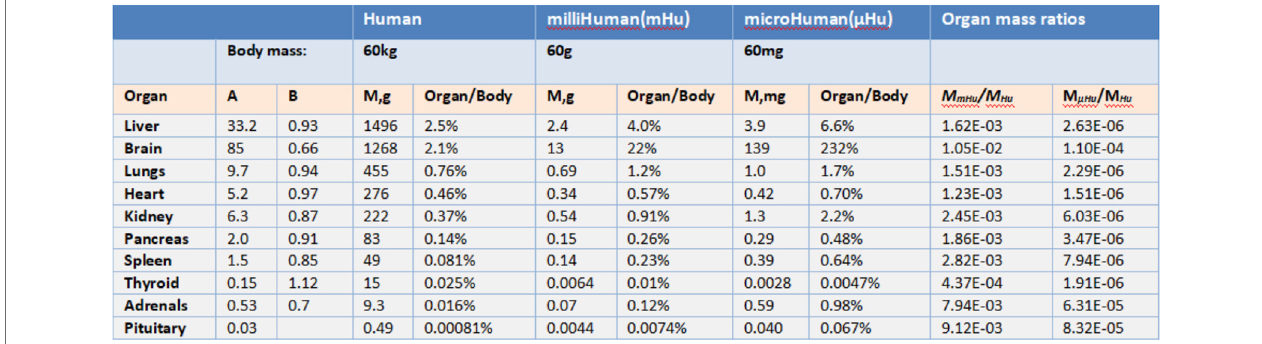
Frontiers in Bioengineering and Biotechnology |